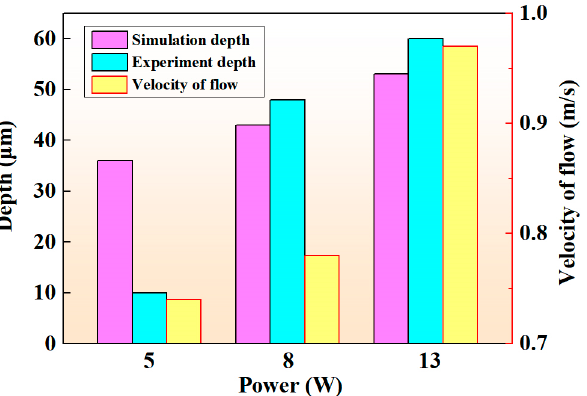
Figure 14. The comparison results of laser ablation depth and the variation of the fl ow velocity at di ff erent average power.